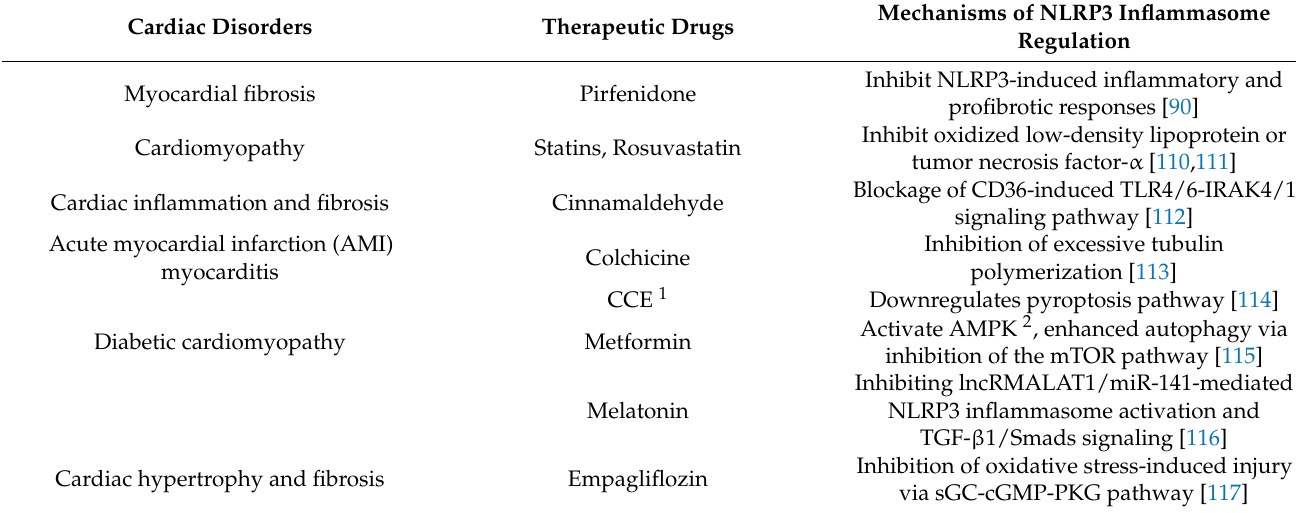
Table 1. Therapeutic compounds targeting inflammasome NLRP3 activation in cardiac